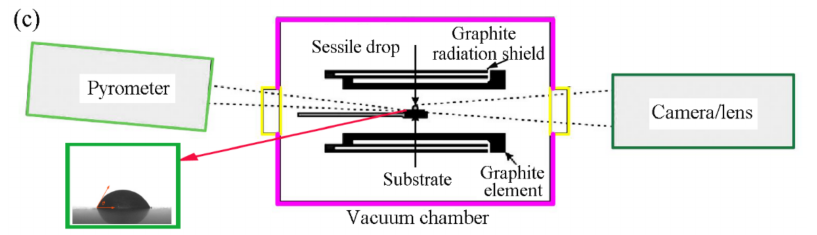
Figure 10. The relationship between the infiltration angles of the models and horizontal graphite heater for measuring the wetting angle ( θ ). ( a ) Al–Cu–Pyrocarbon; ( b ) Al–Cu–Al 4 C 3 –Pyrocarbon; and ( c ) the schematic diagram of sessile furnace.